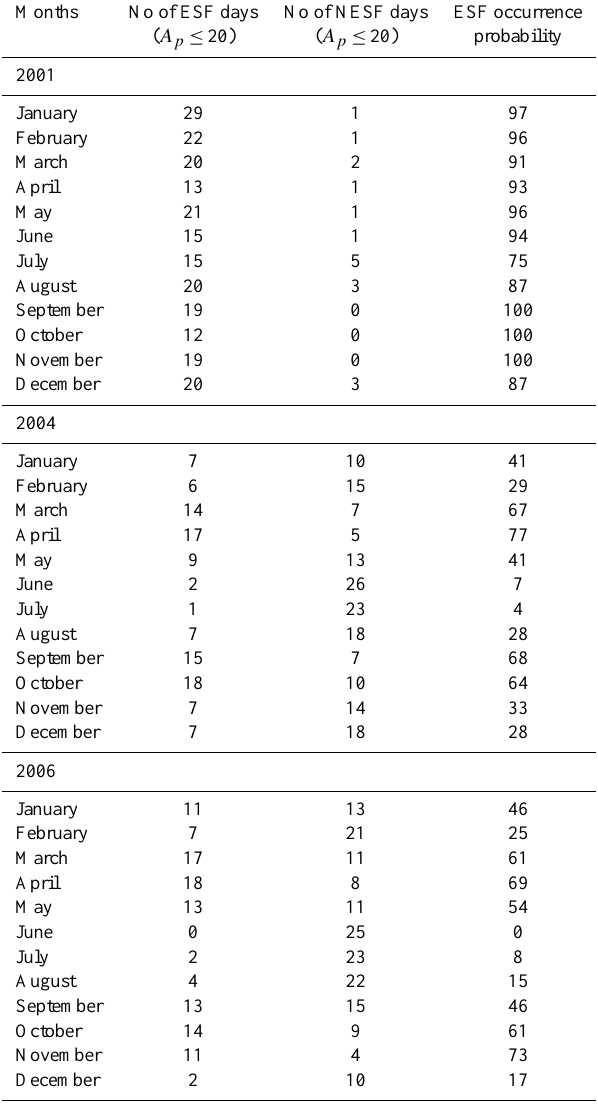
Table 1. Variations in the monthly occurrence pattern of the ESF and the non-ESF days along with the ESF percentage occurrence probability during each month of the solar maximum year of 2001, moderate activity year of 2004 and the solar minimum year of